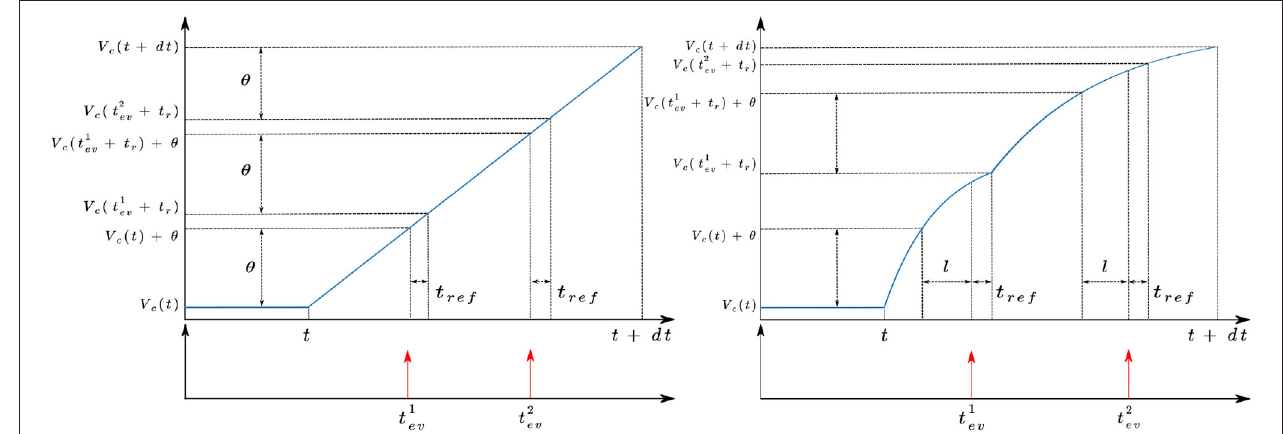
FIGURE 3 | Behavior of the ESIM (left) and ICNS (right) models between two simulated images at time t and t